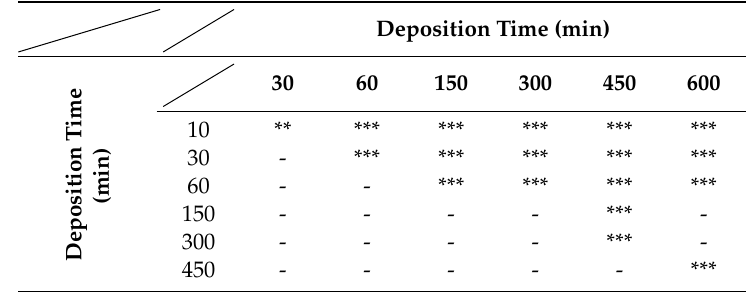
Table 3. Statistical analysis of the average Feret’s diameter of the pores across a variety of surfaces.